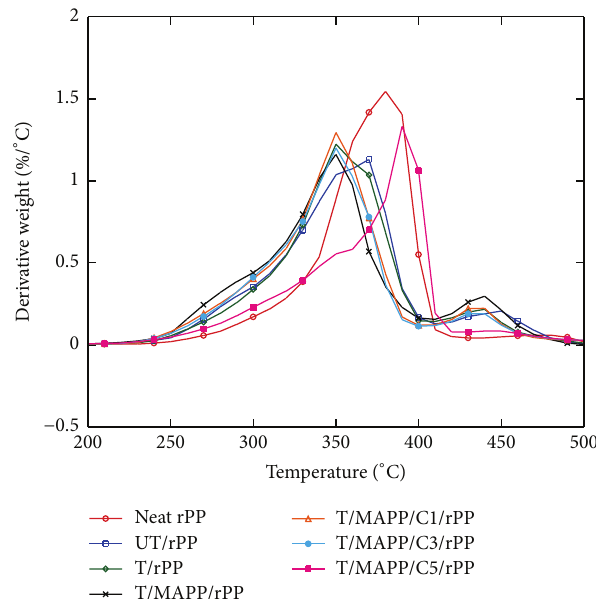
Figure 7: Effect of fiber treatment and nanoclay on DTG curves of rPP and SF/rPP composites.